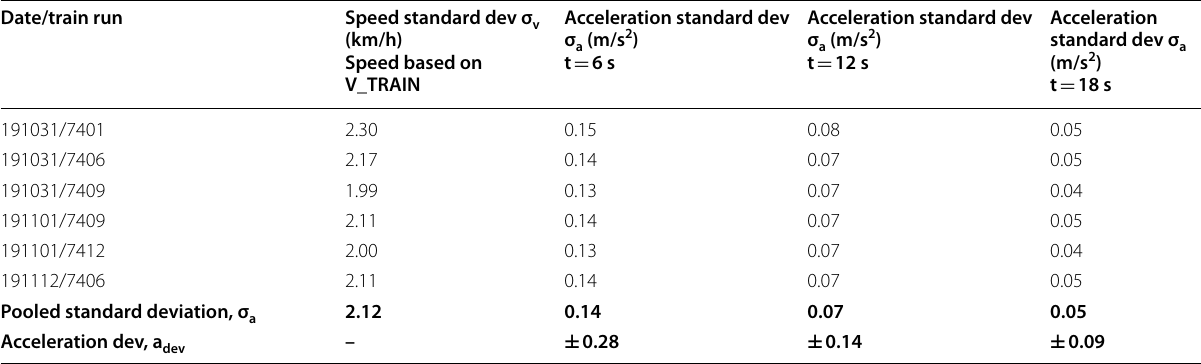
Table 6 Train acceleration validation based on V_TRAIN speed (Alternative